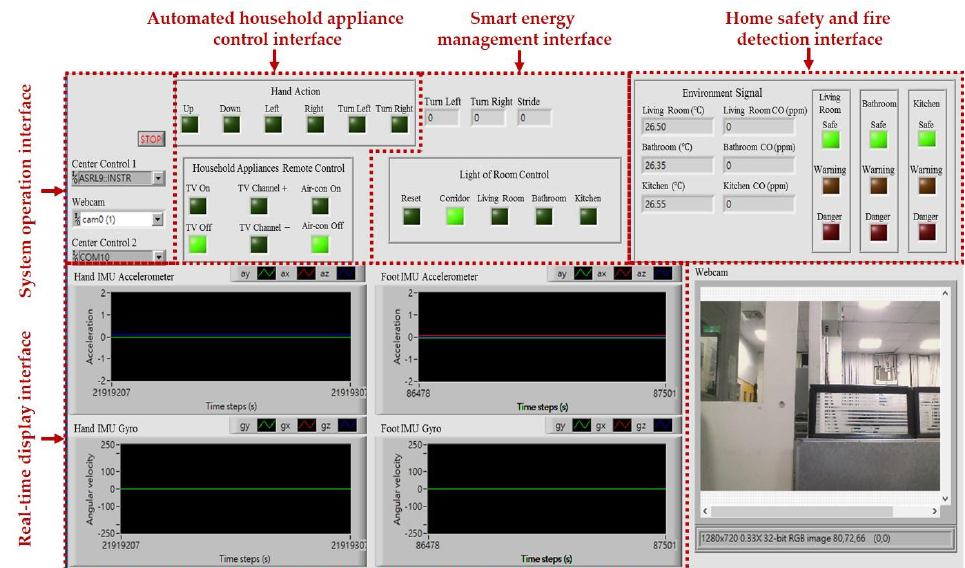
Figure 6. Intelligent monitoring interface for the smart home.